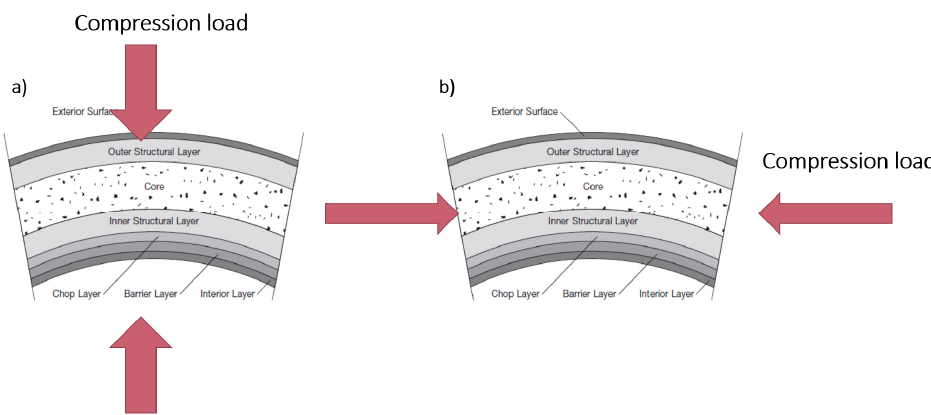
Figure 4. Compression loading direction is either ( a ) transverse or ( b ) longitudinal.